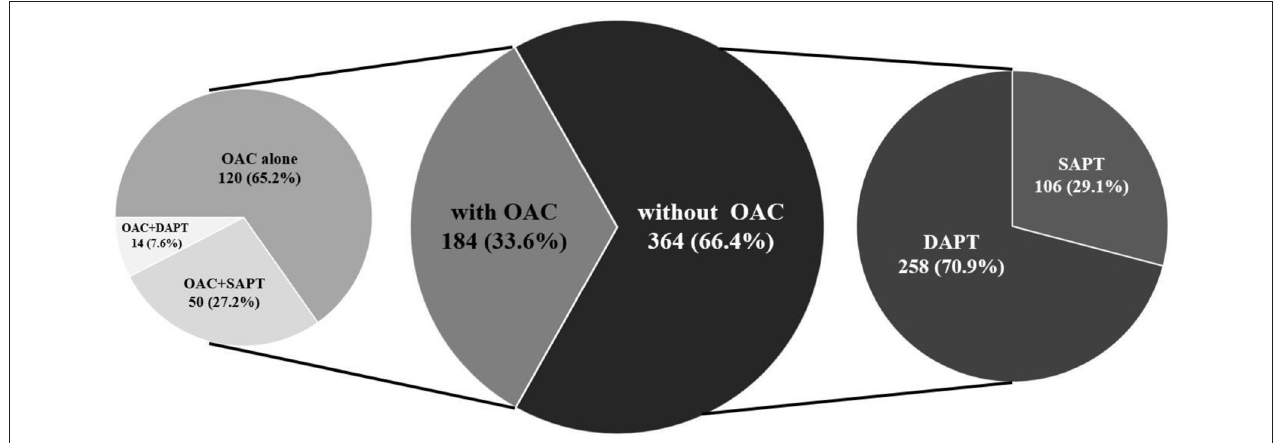
FIGURE 3 | Distribution of antithrombotic strategies by CHA 2 DS 2 -VASc score (A) and HAS-BLED score (B) . OAC, oral anticoagulant.